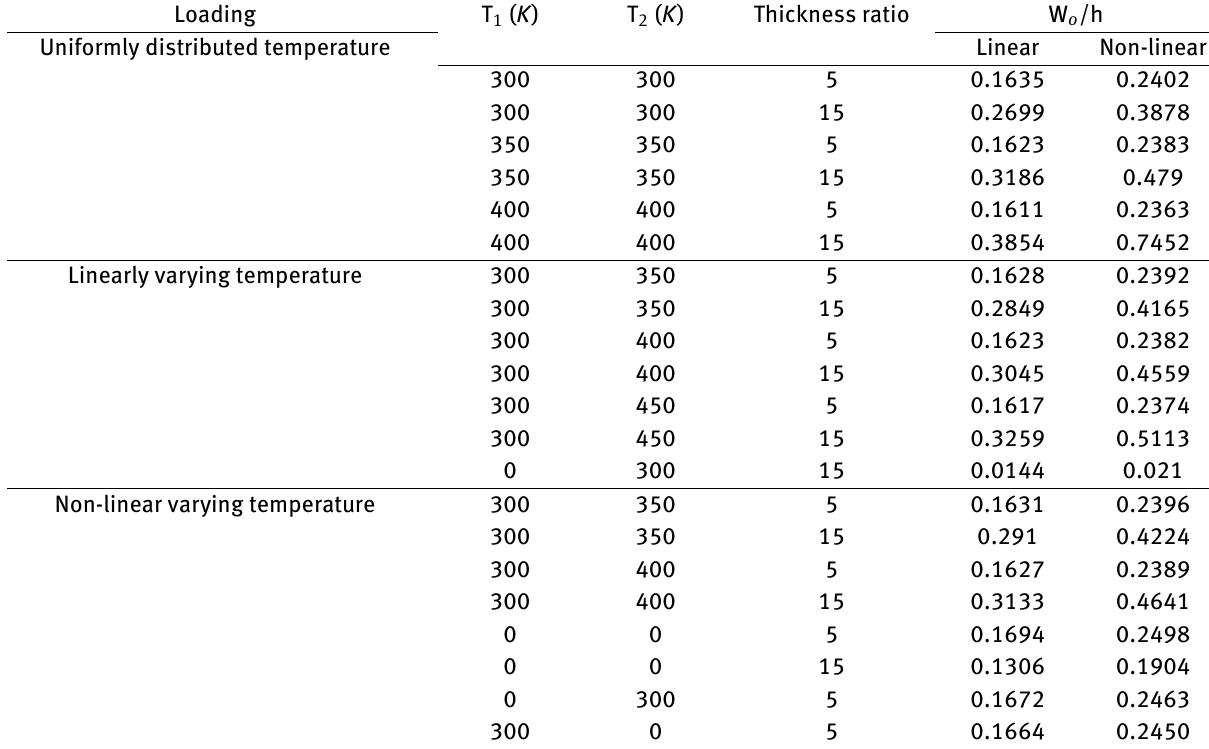
Table 5: Effect of Uniform, linear and nonlinear temperature distribution on transverse central deflection of SWCNT sandwich beam Loading T 1 ( K ) Thickness ratio Uniformly distributed